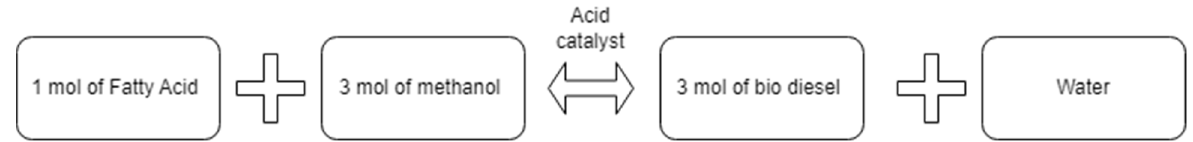
Figure 6. Esterification reaction of biodiesel from fatty acids.